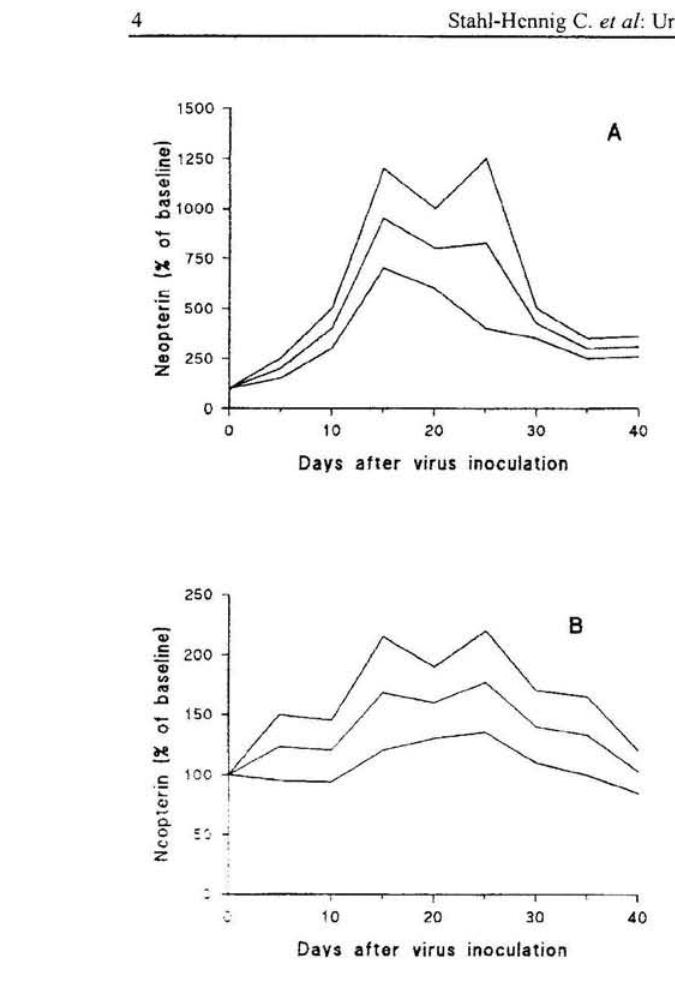
Figure 1 : Course of urinary neopterin concentrations (mean ± S.E.M.) in rhesus and cynomolgus monkeys after inoculation with SIV or HIV-2. Neopterin con- centrations obtained after inoculation were related to preinoculation values and expressed as percent of mean baseline values. The dragram shows the mean neopterin concentrations of (A) rhesus monkeys after infection with SIV (n=9; animal No. 5025, 5026, 1689, 1705, 5024, 5028, 5129, 5133, 5019 from Table 1) and of (B) cynomolgus monkeys after infection with HIV- 2ben (n=7; animal No. 5172, 5173, 5344, 5345, 5346, 5170, 5171 from Table 1). cs from 98% to 477%. No significant differences were tions of seroconverted and non-seroconverted animals.